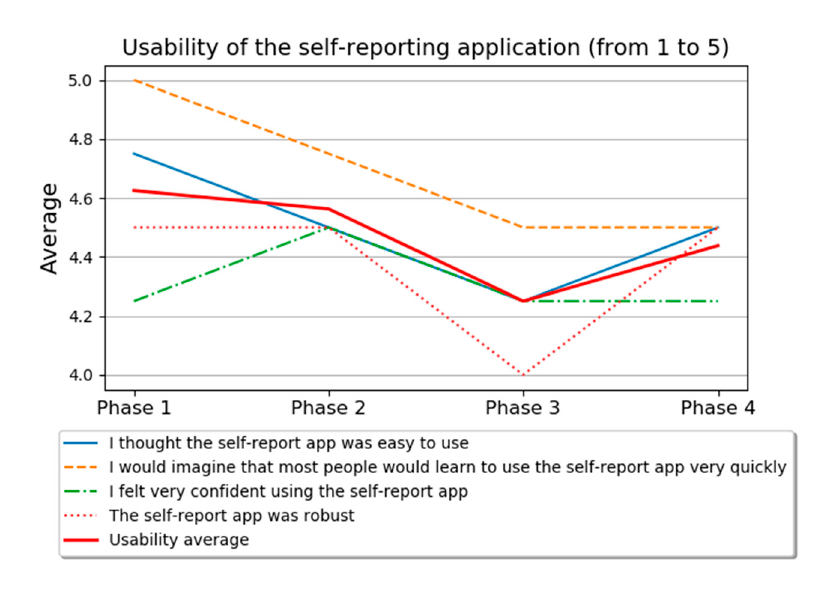
Figure 5. Usability items related to self-report application by